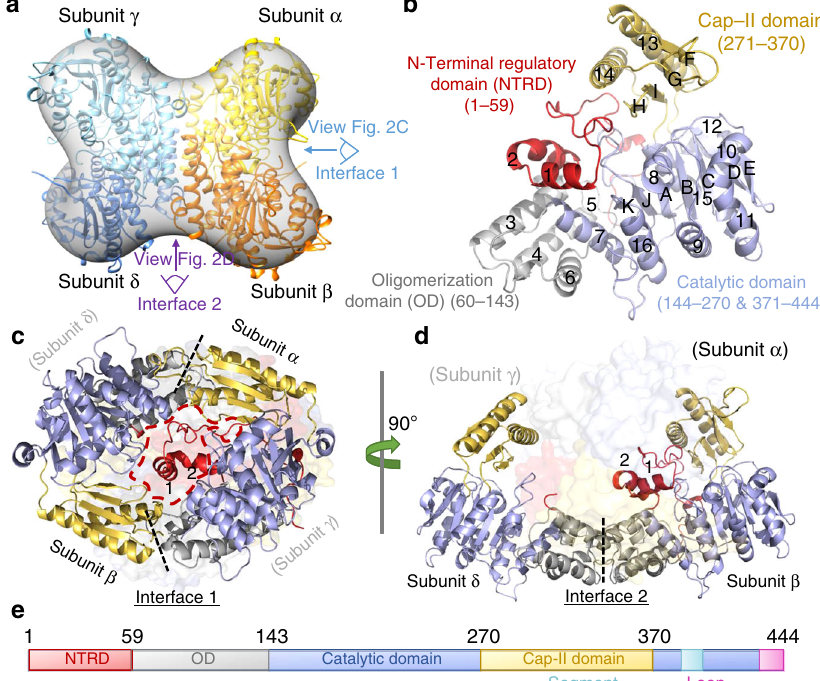
Fig. 2 Overall structure of the Pf ISN1 apoenzyme. a Crystal structure of the tetrameric Pf ISN1-Apo form. The structure has been fi tted within the 25 Å resolution envelope calculated after single particle reconstruction from negatively stained samples. Each subunit constituting the homo-tetramer displays different colour coding. The orientation as seen in Fig. 2c, d are indicated. b A subunit (monomer) of Pf ISN1 with the N-terminal regulatory domain (NTRD) in red, the oligomerization domain (OD) in grey, the catalytic domain in blue and the cap domain in yellow. α -Helices are numbered from 1 to 16 and β - strands from A to K. c Dimer interface 1. Dashed lines indicate the dimer interfaces formed by the interaction between the OD of one subunit and the cap domain of another subunit. Subunits γ and δ (light grey) reside behind subunits β (left-hand side) and α (right-hand side), respectively. The red dashed contour delimits the cavity which accommodates an NTRD from subunit α . d Dimer interface 2. The dashed line indicates the dimer interface formed by the interaction between two OD ’ s of subunits β and δ . Subunits in parentheses are depicted as surfaces while subunits in light grey are situated in the background (not visible in the fi gure). e Schematic linear illustration of Pf ISN1, with the colour code used in other panels, and with Segment D394-R406 in cyan and Loop L430-Q444 in